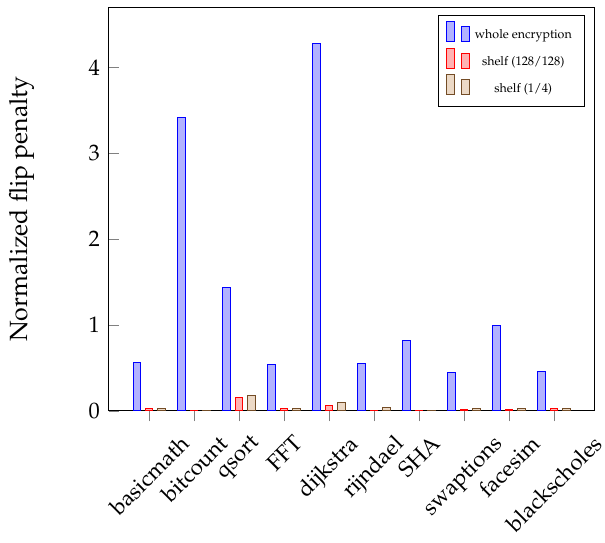
Figure 4. The normalized flip penalty.